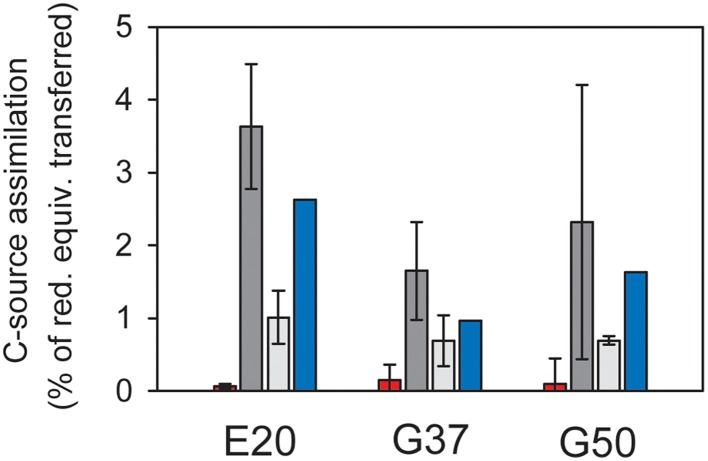
Assimilation of carbon sources in relation to reducing equivalent transfer assuming an average oxidation state of organic carbon of 0. Red = methane carbon assimilation; light gray = DIC assimilation in the absence of methane; dark gray = DIC assimilation in the presence of methane; error bars = standard deviation, n = 3 per treatment; blue bars = methane-dependent DIC assimilation as difference between incubations with and without methane, therefore no error bars. In all cultures assimilation of inorganic carbon strongly exceeds methane carbon assimilation, suggesting that the latter is likely methane-derived DIC assimilation.